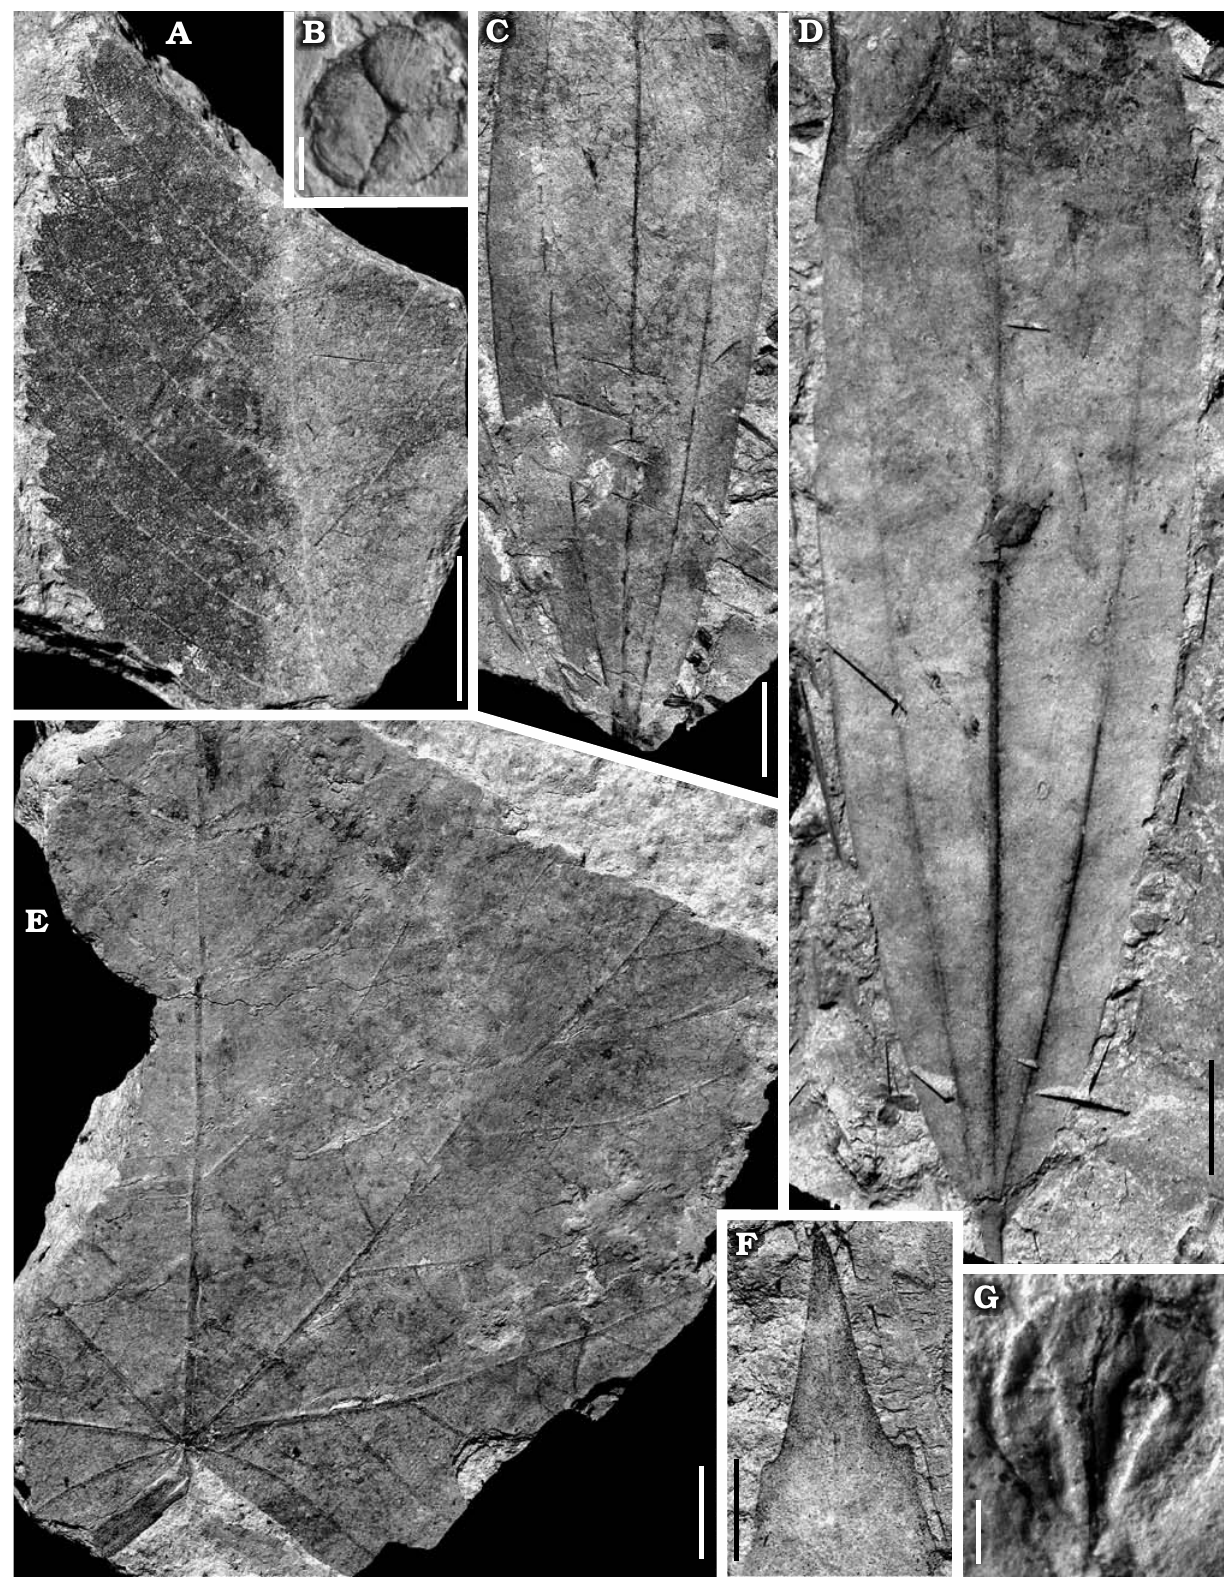
Fig. 5. Angiosperms impressions from Ł ysa Góra near R ę biszów, Poland, late Oligocene. A . Carpinus sp. vel Ostrya sp., KRAM-P 128/546, leaf. B . Paliurus favonii Unger, 1847, KRAM-P 128/165, fruit. C , D , F . Majanthemophyllum basinerve (Rossmässler, 1840) Knobloch and Kva č ek, 1996, leaves. C . KRAM-P 128/571. D . KRAM-P 128/289. F . KRAM-P 128/212. E . Vitis sp. or Ampelopsis sp., KRAM-P 128/205, leaf. G . Ampelopsis cf. rotundata Chandler, 1925, KRAM-P 128/109, seed. Scale bars: A, C–F, 10 mm; B, G, 1